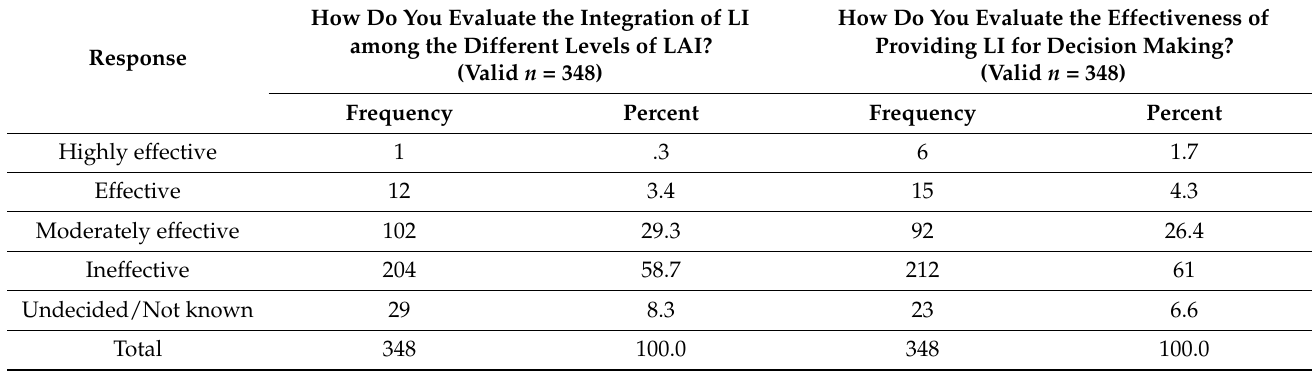
Table 4. Responses of HH’s on the integration levels and provision of LI for decision